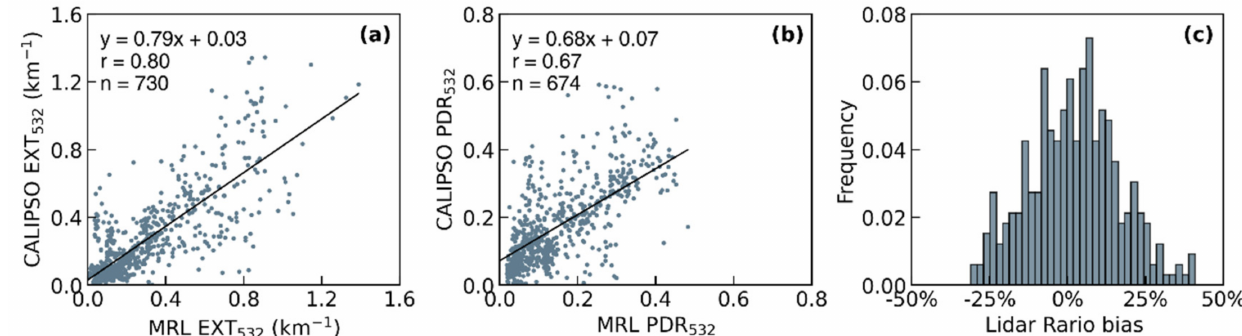
Figure 8. Comparison of the EXT 532 , PDR 532 , and lidar ratio between MRL and CALIPSO. Scatter plots show relationship between MRL and CAPLISO for ( a ) EXT 532 and ( b ) PDR 532 . ( c ) The relative bias between LR 532 assumed by CALIPSO and LR 355 measured by MRL. The correlation coefficients in (a) and (b) are shown at the top left, n = number of samples. The steps of relative bias of lidar ratio is